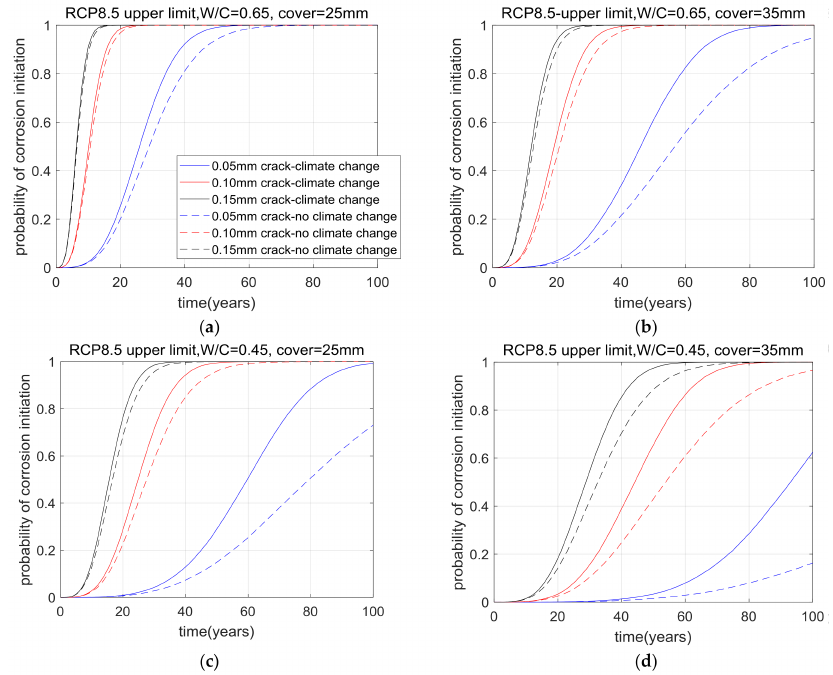
Figure 11. Probability of corrosion initiation-RCP 8.5 upper 90% confidence interval, time slice 2000. ( a ) W/C: 0.65, Cover depth: 25 mm; ( b ) W/C: 0.65, Cover depth: 35 mm; ( c ) W/C: 0.45, Cover depth: 25 mm; ( d ) W/C: 0.45, Cover depth: 35